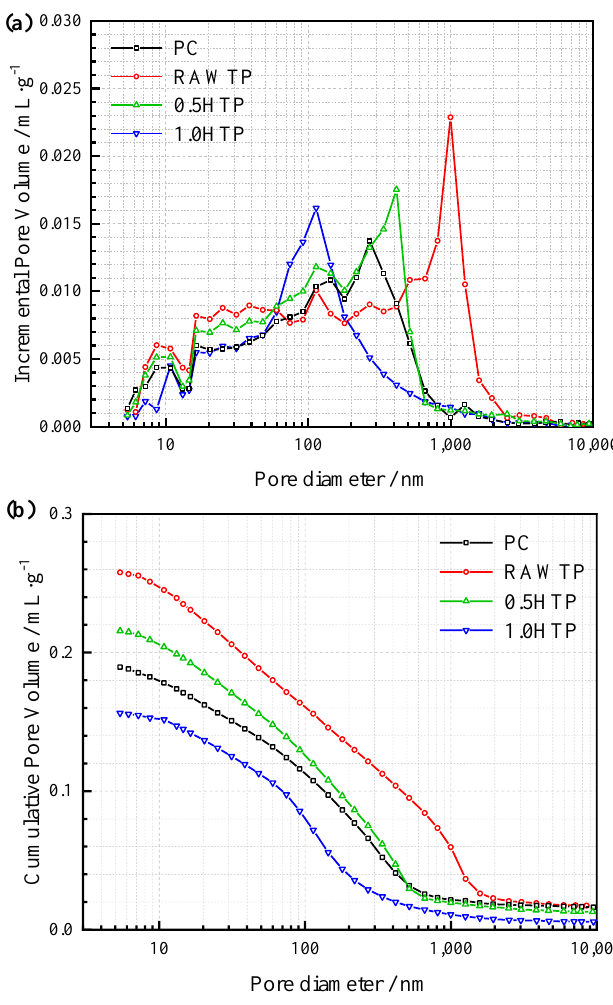
Figure 15. Incremental ( a ) and cumulative ( b ) pore volumes of cementitious pastes.